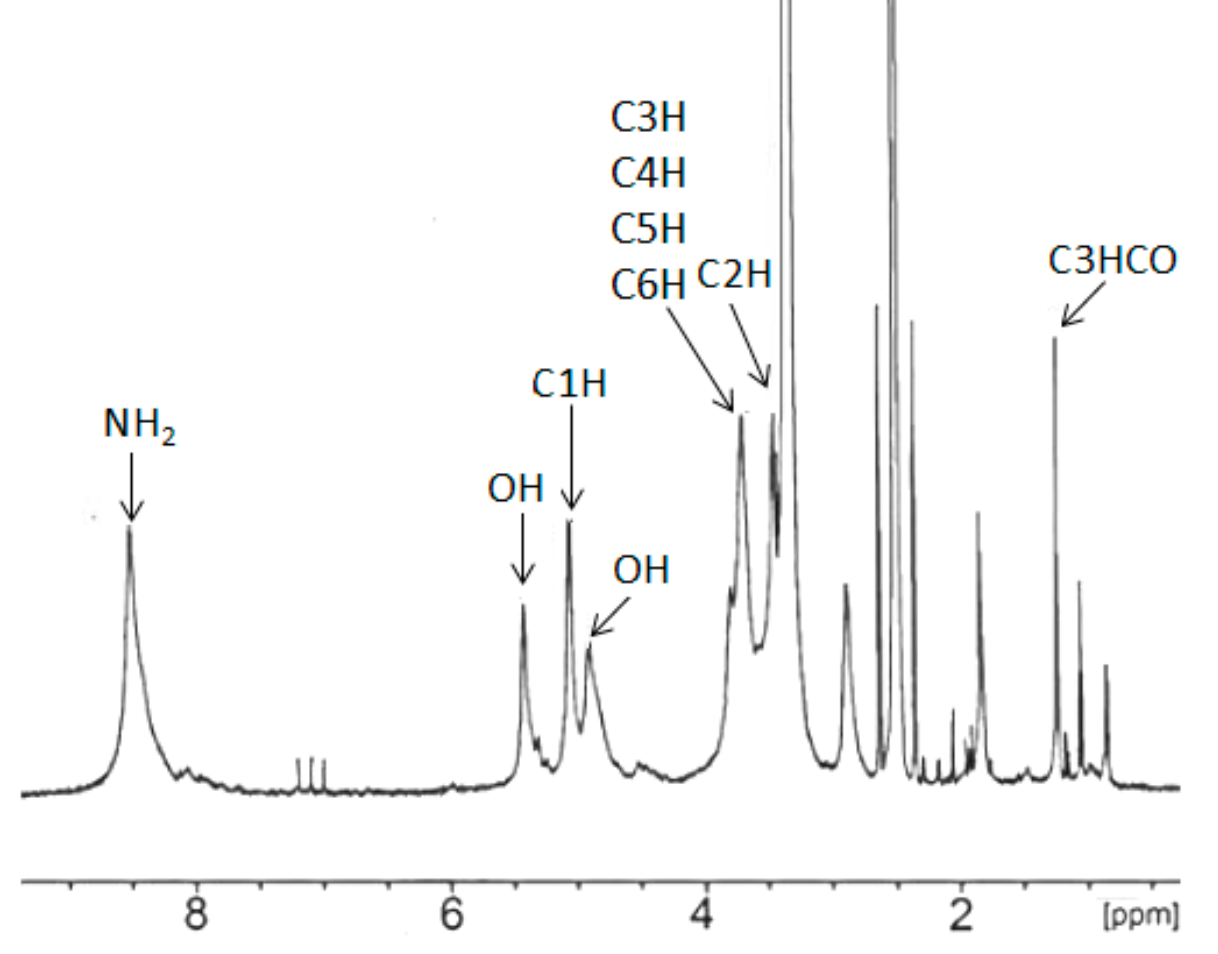
Figure 3. 1 H-NMR spectrum of water-soluble chitosan.